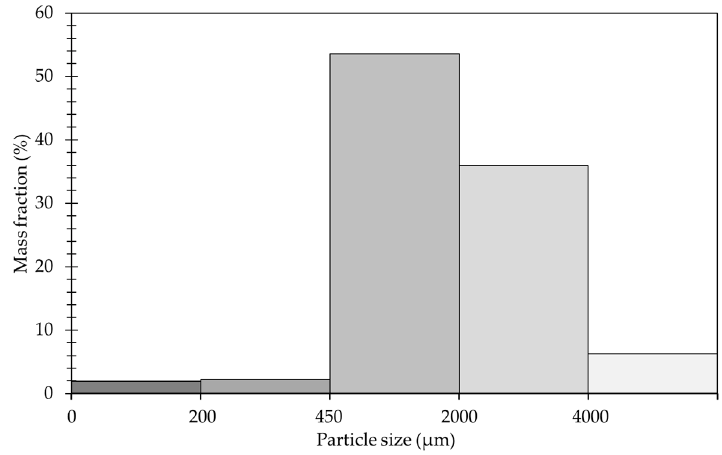
Figure 1. Particle size distribution of dried red vine leaves.